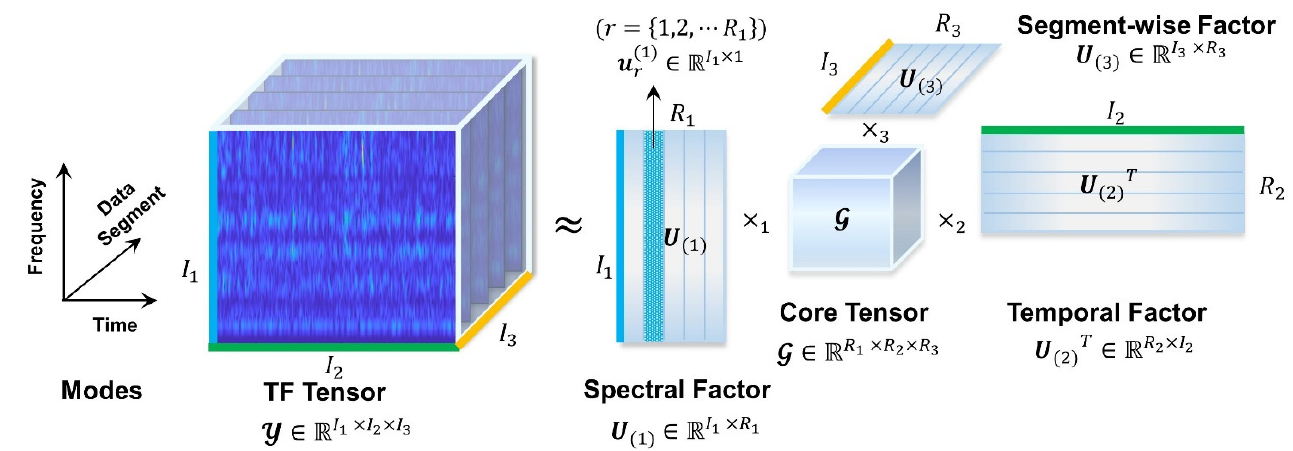
Figure 3. An illustration of the tensor decomposition model for TF tensor factorization.